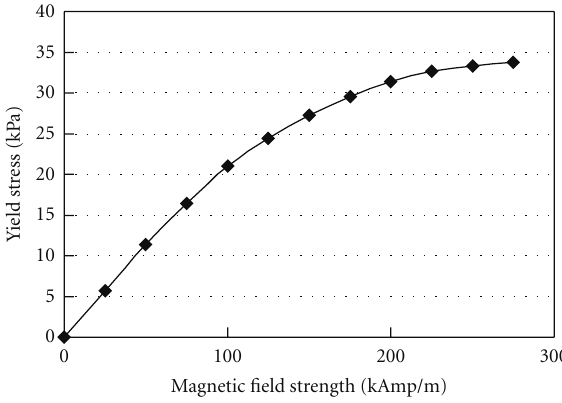
Figure 4: Yield stress versus magnetic field strength.